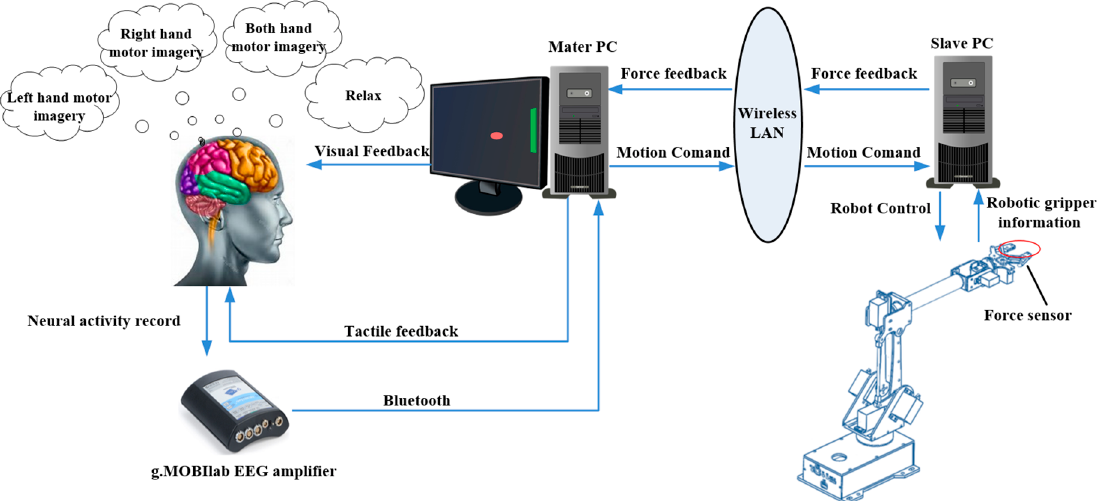
Figure 1. Motor imagery EEG-based continuous teleoperation robot control system with biofeedback.